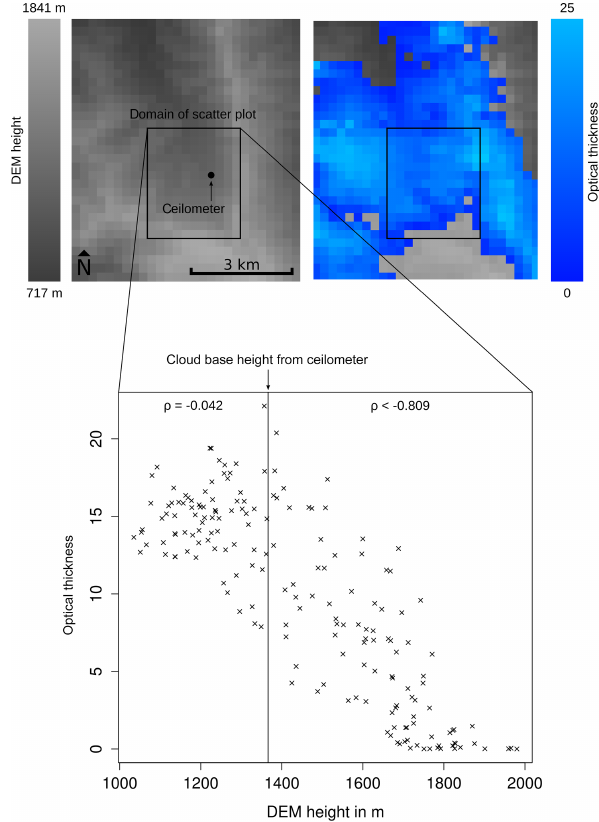
Figure 4. Relationship between the optical thickness of a cloud par- tially touching the ground and the terrain height in Xitou, Taiwan, on 31 November 2014. The lower plot is based on all cloud pix- els inside the plot domain. For pixels above the ceilometer-derived cloud base ground contact of the cloud can be assumed under the as- sumption of plane-parallelism. The cloud base height was detected by a ground-based ceilometer (cf. Sect. 4.2 for information about the ceilometer and the location). The ASTER GDEM 2 resampled to a resolution of 250m (cf. Sect. 3) has been used for the terrain height. The optical thickness was taken from a sharpened 250m version of the MODIS MOD 06 product (cf. Sect.